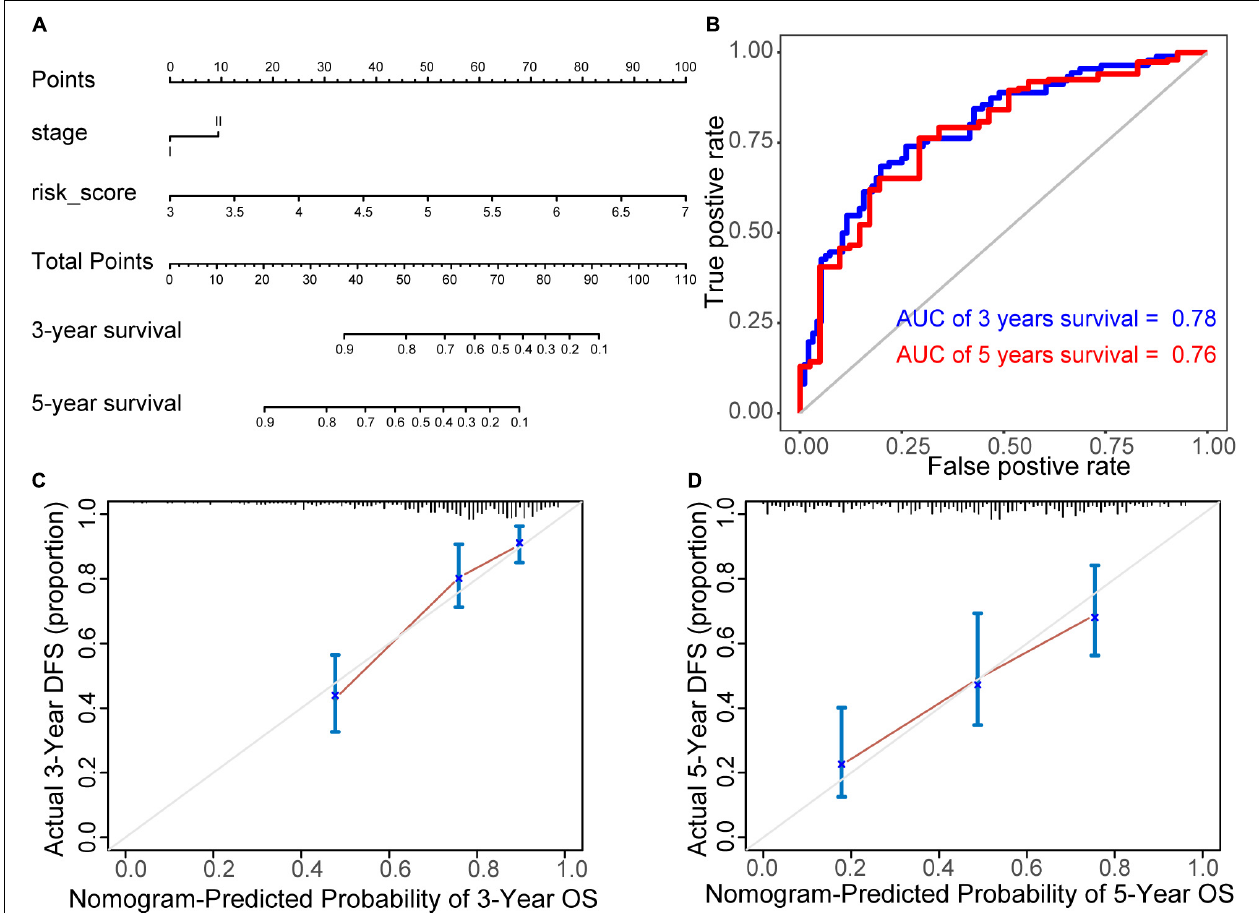
FIGURE 7 | Construction of prognostic nomogram. (A) Nomogram for predicting 3- and 5-year survival probability, by integrating 21 biomarkers, age, risk score, sex, and tumor stage. (B) ROC curves of the nomogram. In the time-dependent ROC curve, the nomogram also displayed a robust performance in predicting the 3- and 5-year survival rates. The AUC was 0.78 and 0.76, respectively. (C,D) The calibration curves of 3- and 5-year survival rates. They showed an optimal agreement between the nomogram predictions and actual